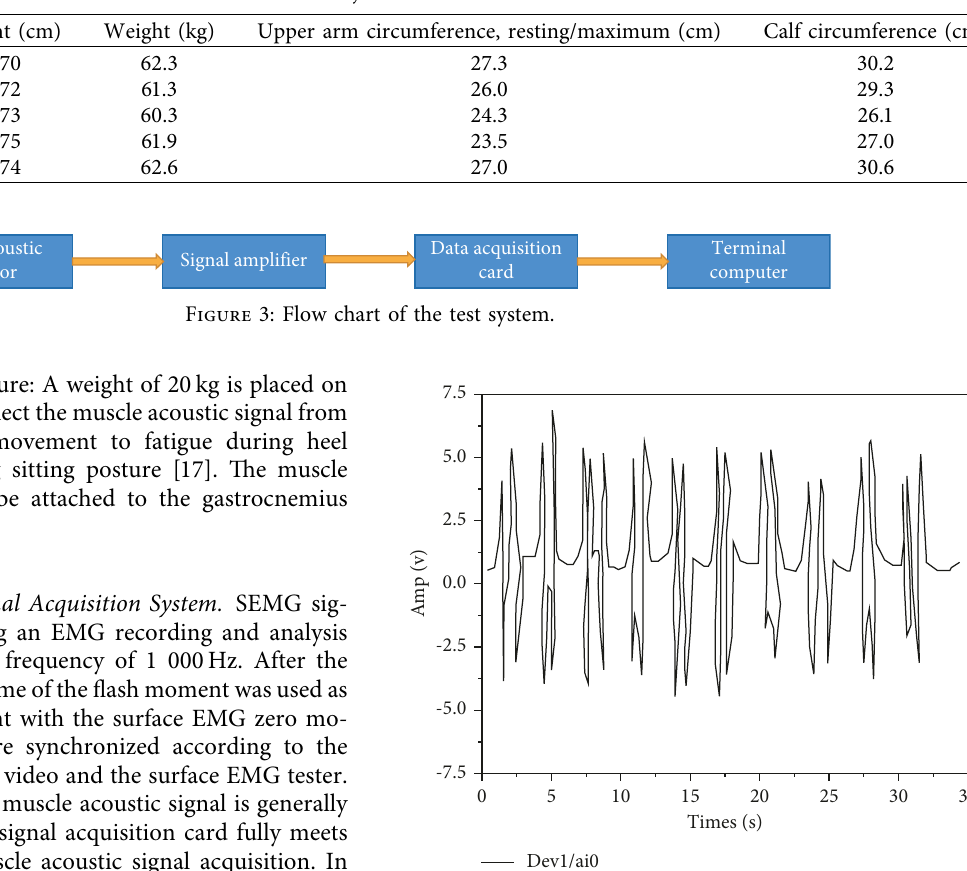
Figure 4: Acoustic signal of biceps brachii during curling exercise.